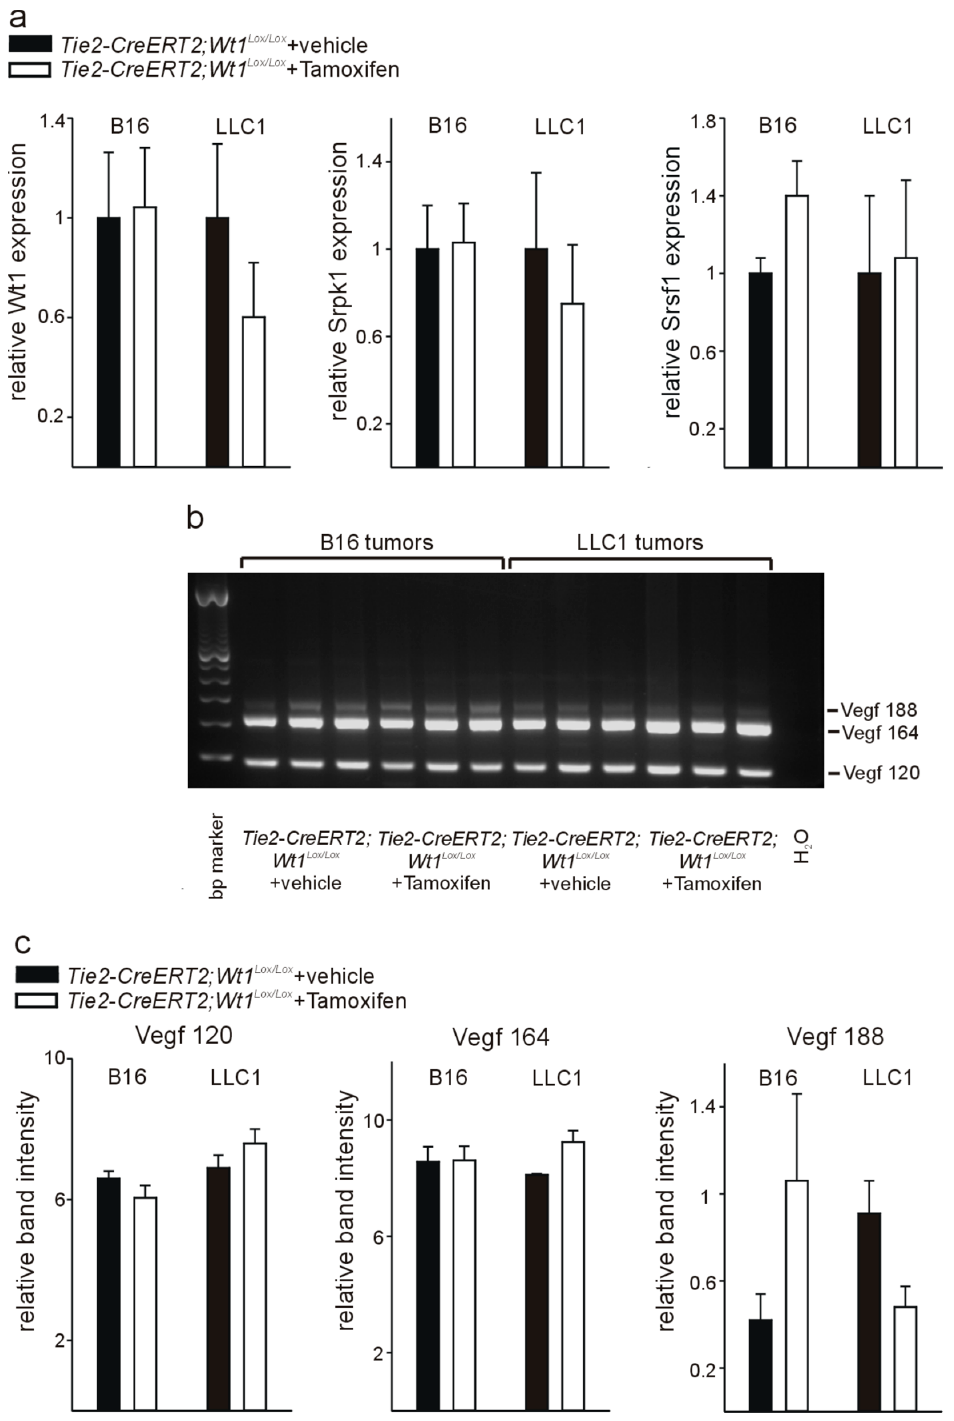
Figure 5. Determination of Wt1, Srpk1 and Srsf1 expression and Vegf isoform distribution in whole tumor samples from Tie2-Cre ERT2 ; Wt1 Lox/Lox mice treated with Tamoxifen compared to vehicle-treated controls. ( a ) Expression levels of Wt1, Srpk1 and Srsf1 were determined by quantitative RT-PCR on B16 and LLC1 tumor samples from Tie2-Cre ERT2 ; Wt1 Lox/Lox mice treated with Tamoxifen compared to vehicle-treated controls ( n = 6 each). Expression of each gene was normalized to the respective arithmetic means of Gapdh , Actnb, and Rplp0 expression. ( b ) Vegf isoforms (Vegf 188: 293 bp; Vegf 164: 221 bp; Vegf 120: 89 bp) were determined by PCR as described [18] in samples of B16 and LLC1 tumors isolated from Tie2-Cre ERT2 ; Wt1 Lox/Lox mice treated with Tamoxifen compared to vehicle-treated controls ( n = 3 each). ( c ) Quantification of relative band intensities for the different Vegf